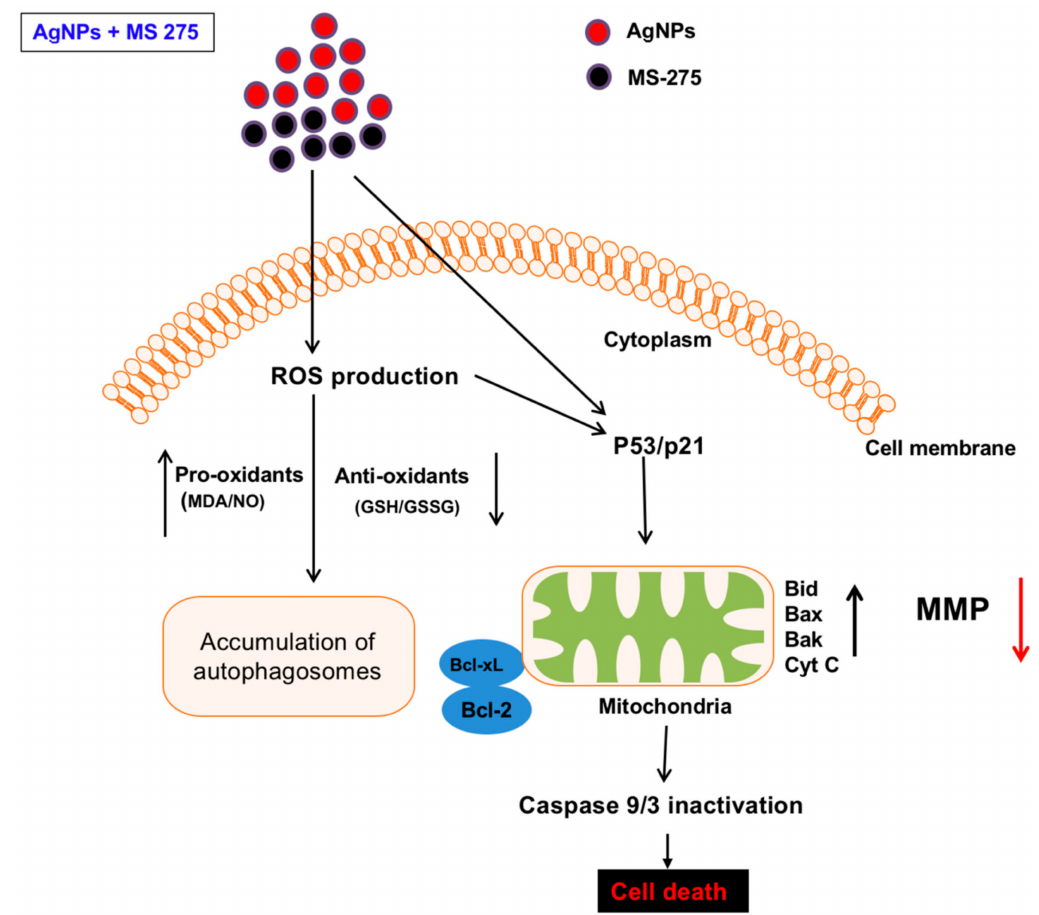
Figure 12. AgNPs and MS-275 induce cytotoxicity and apoptosis. Cell death is initiated by entry of AgNPs and MS-275 into the cells, which then triggers ROS production, LDH leakage, increase of pro-oxidants, and decrease of antioxidants, which leads to cytotoxicity. Altering of mitochondrial membrane potential (MMP) subsequently results in the release of pro-apoptotic mitochondrial proteins into the cytosol. This activates caspase-dependent processes culminating in cell death. Loss of